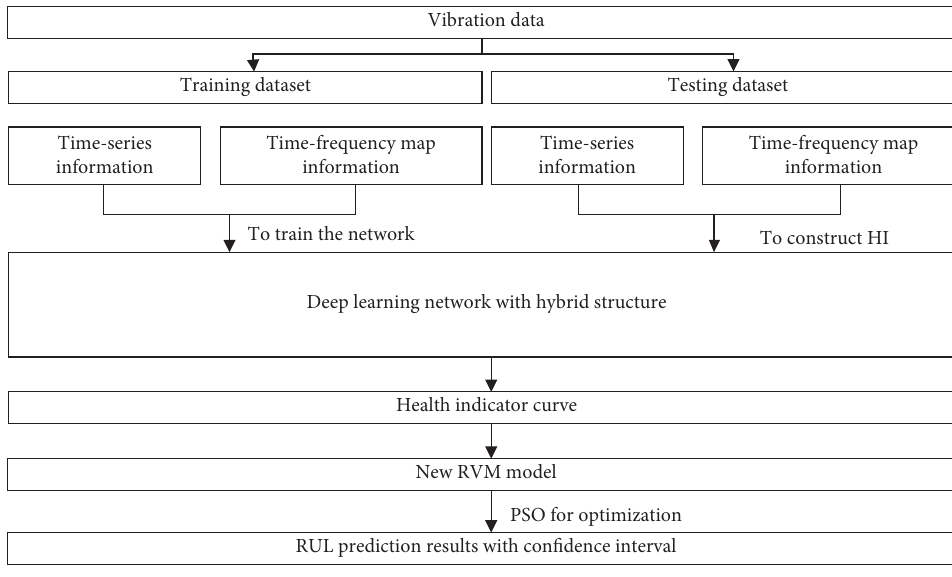
Figure 2: The proposed RUL scheme.